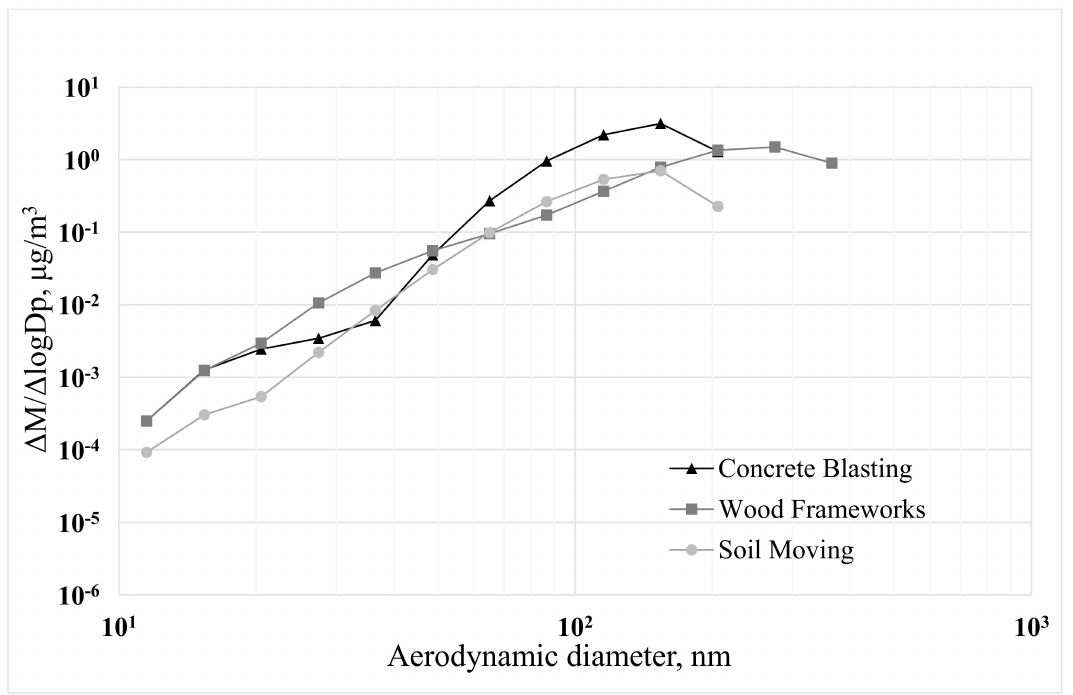
Figure 1. Size distributions of ultrafine particles at three different construction sites during the experiments with pleated N95 filtering facepiece